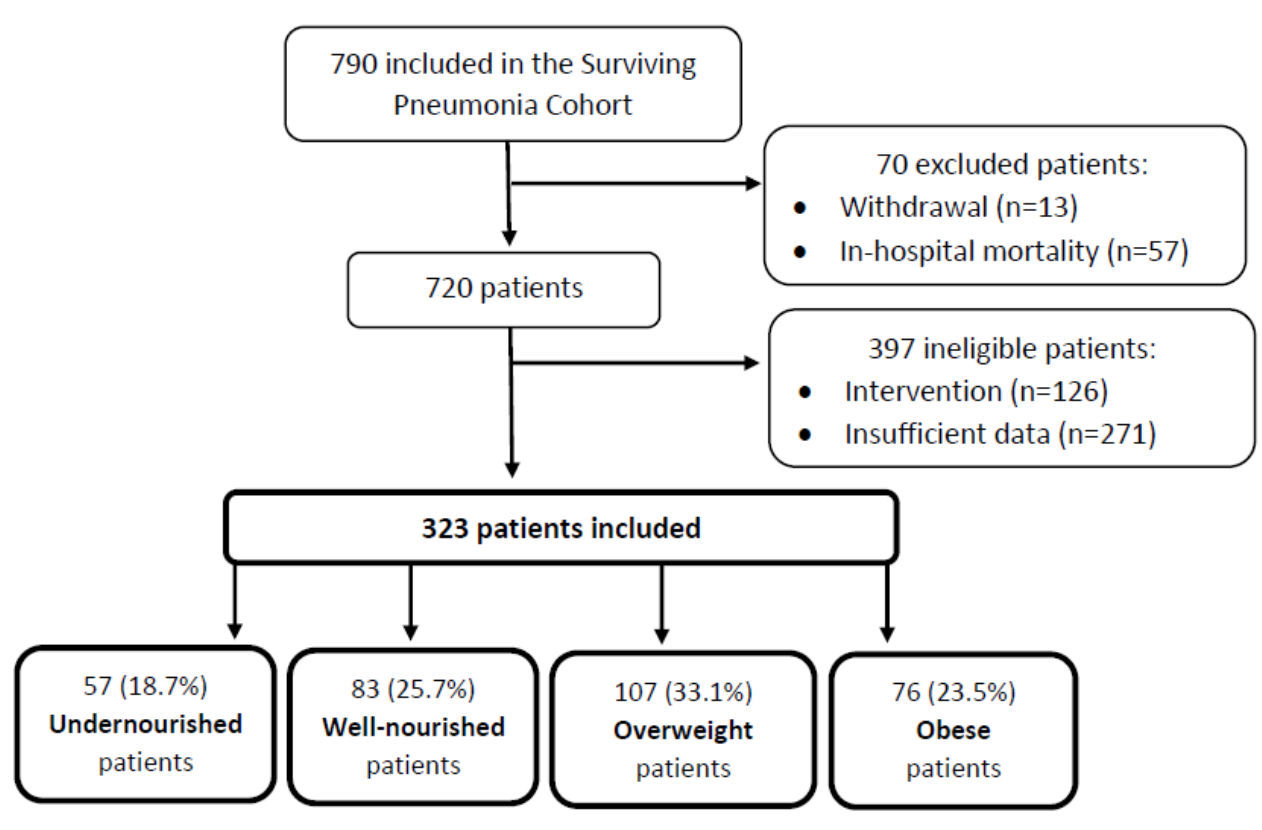
Figure 1. Flow of inclusion in the study.